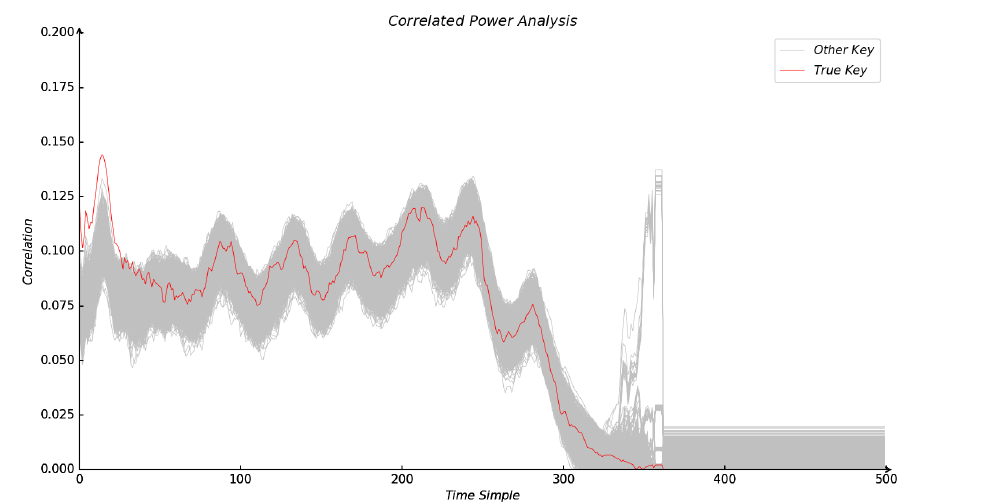
Figure 15. Group D: CPA result of experiment with 3 rounds calculated by